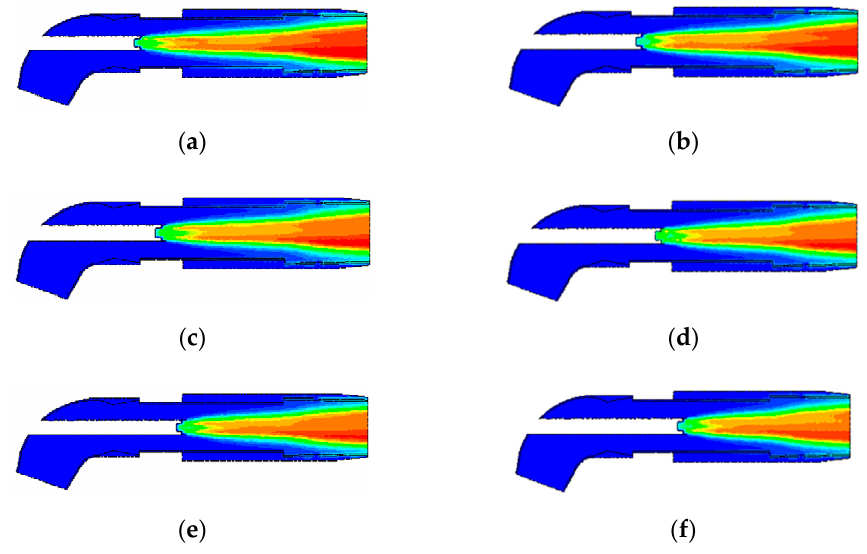
Figure 7. Temperature field (K) of the longitudinal cross section (XZ central cross section) with different extension distance. ( a ) 0 mm, ( b ) 100 mm, ( c ) 200 mm, ( d ) 300 mm, ( e ) 400 mm, ( f ) 500 mm.